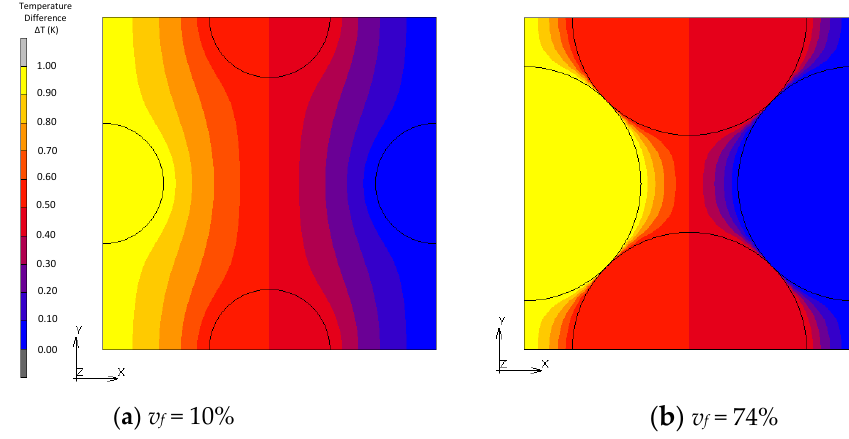
Figure 10. Temperature distribution of FCC models.